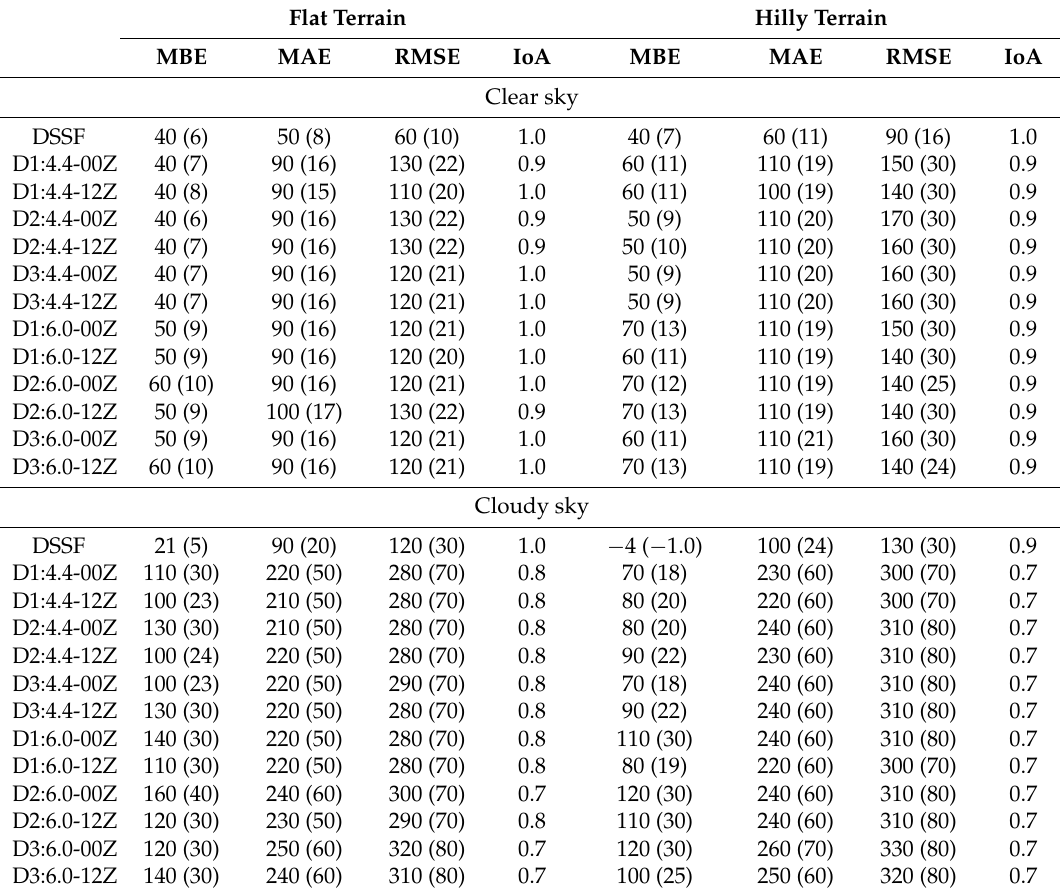
Table 5. Hourly solar radiation error and accuracy statistics, depending on flat or hilly terrain and clear or cloudy conditions, during the summer 2011. MBE, MAE and RMSE in W ¨ m ´ 2 . Relative errors (%) rMBE, rMAE and rRMSE in brackets at the right. Flat Terrain Hilly